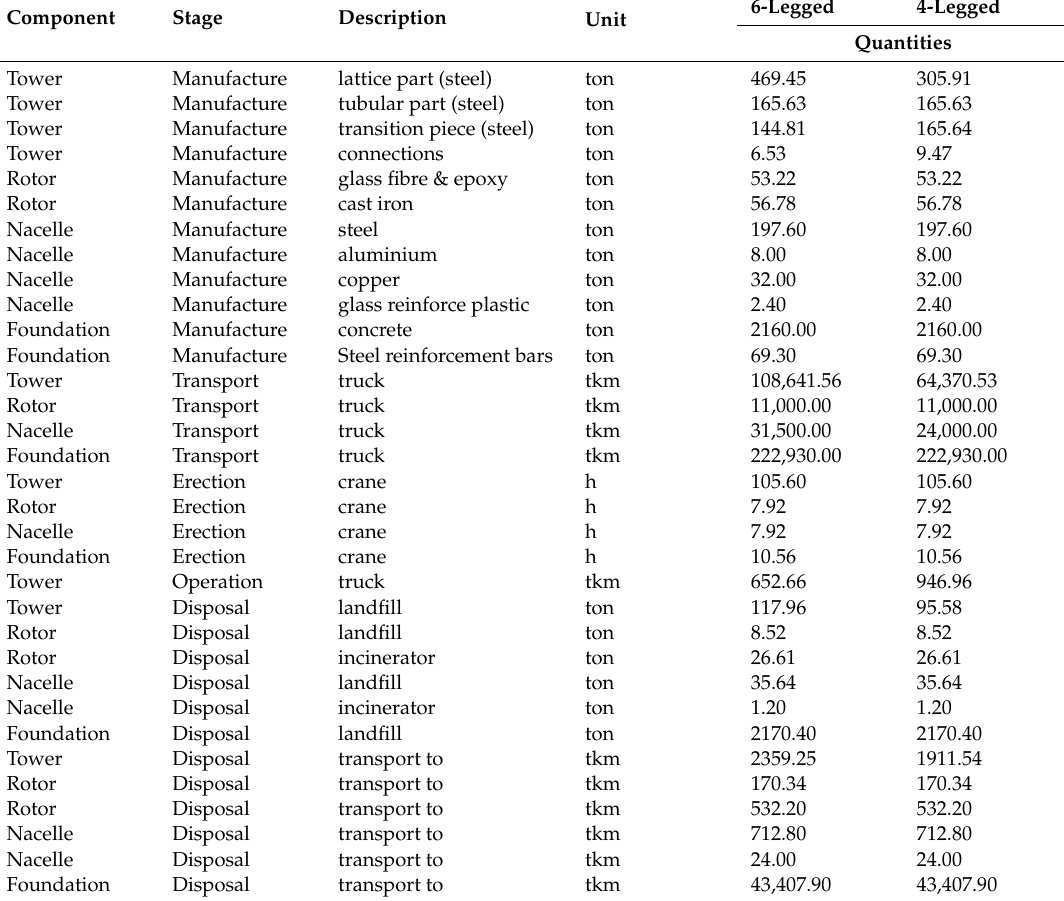
Table 5. Data collection—LCI.